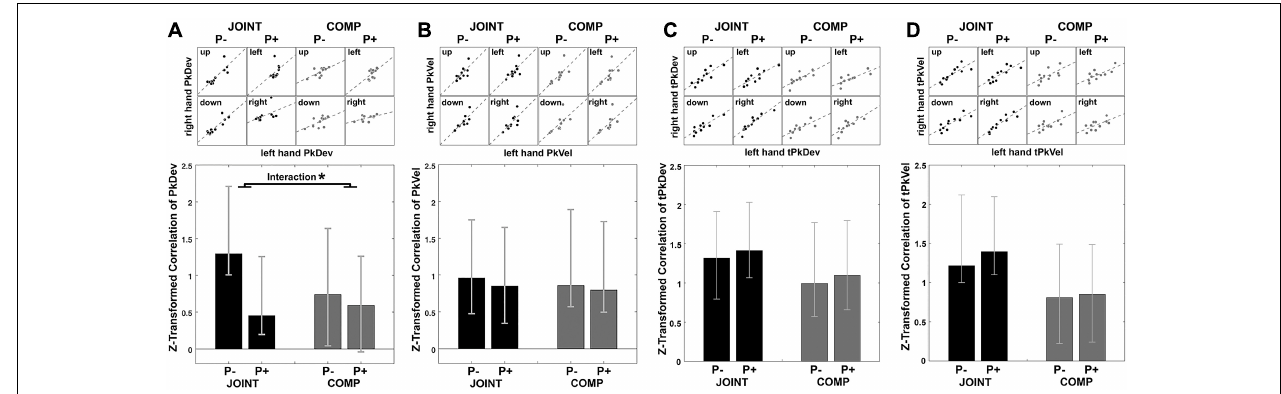
FIGURE 5 | Synchrony of peak finger deviation (A) , peak finger velocity (B) , timing of peak finger deviation (C) , and timing of peak finger velocity (D) between co-actors illustrated by scatterplots for cooperation (JOINT) and competition (COMP) in each rotation condition. Each dot in the scatterplots is the averaged variable of each co-actor. Bar graphs display the Task by Perturbation interaction of z -transformed correlations for each of the four variables, calculated by [(JOINT P– to JOINT P+) – (COMP P– to COMP P+)]. Error bars indicate 95% bootstrapped confidence interval. ∗ Indicates significance as per bootstrapping